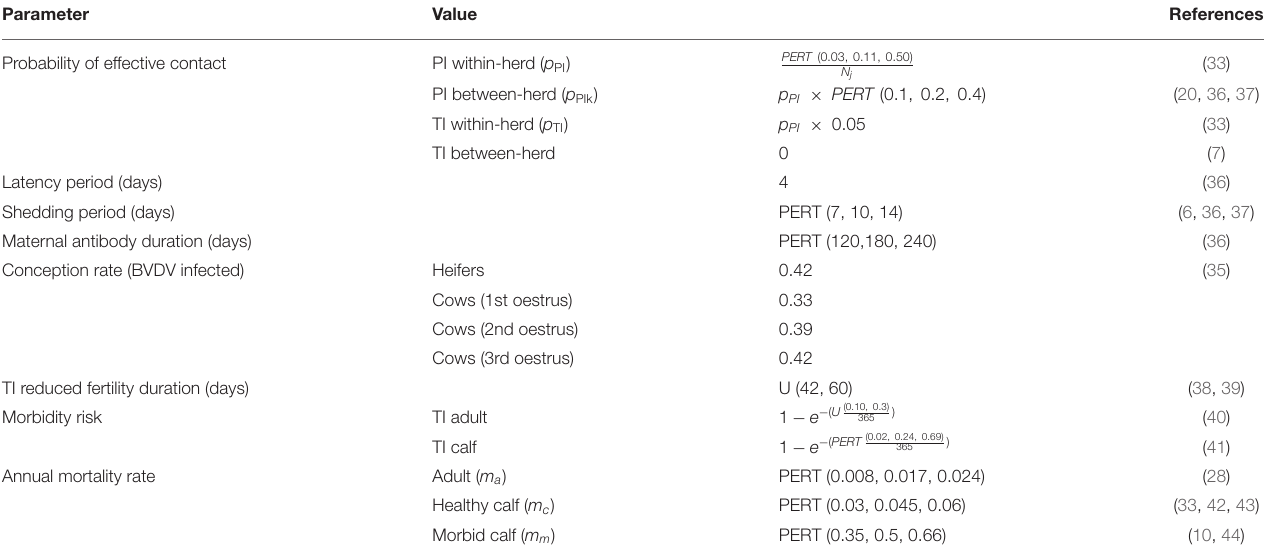
TABLE 2 | Disease parameters used in a simulation model of BVDV in a self-replacing beef herd. Parameter